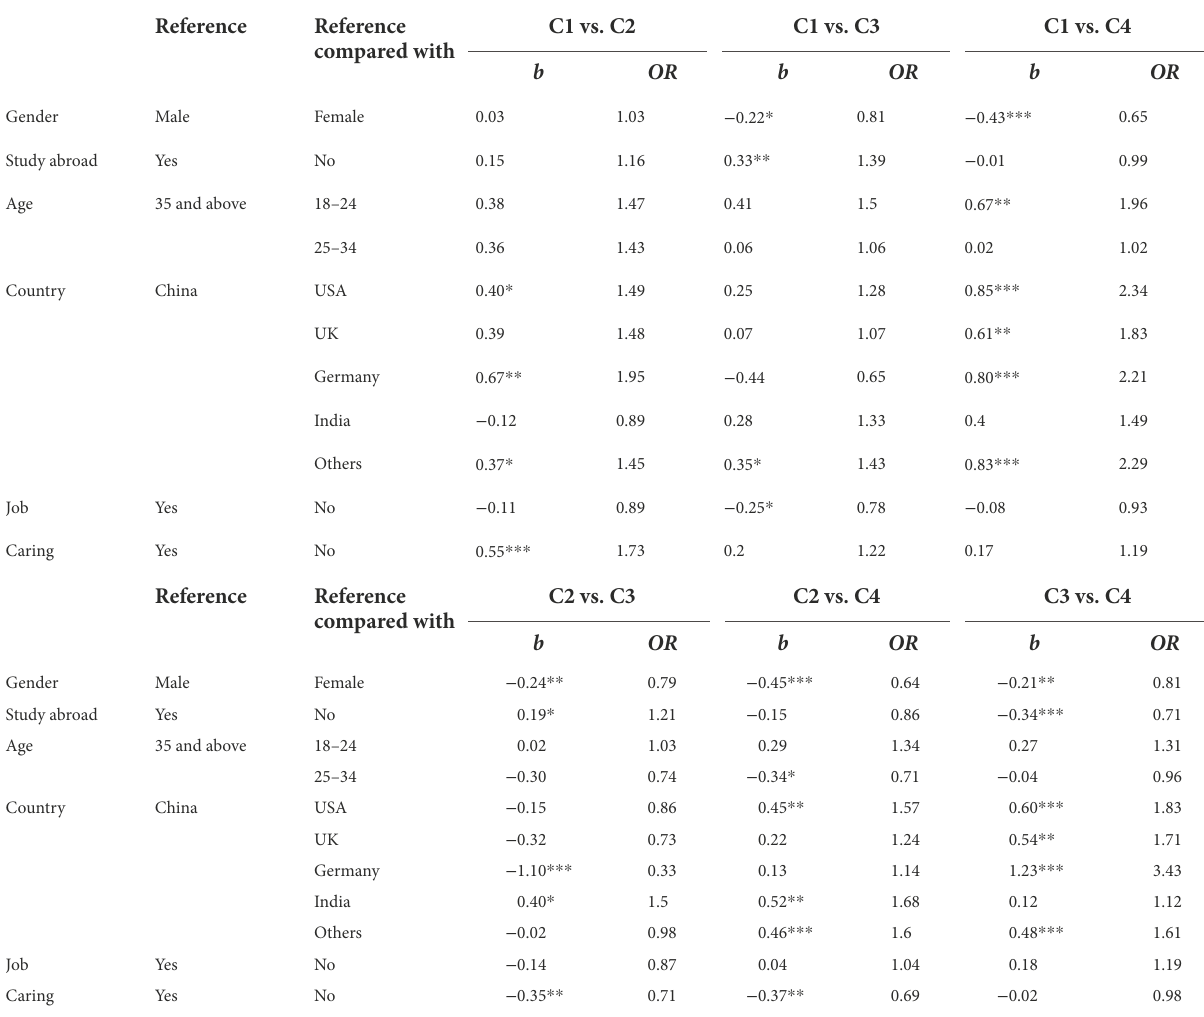
TABLE 5 Association between profiles and demographic